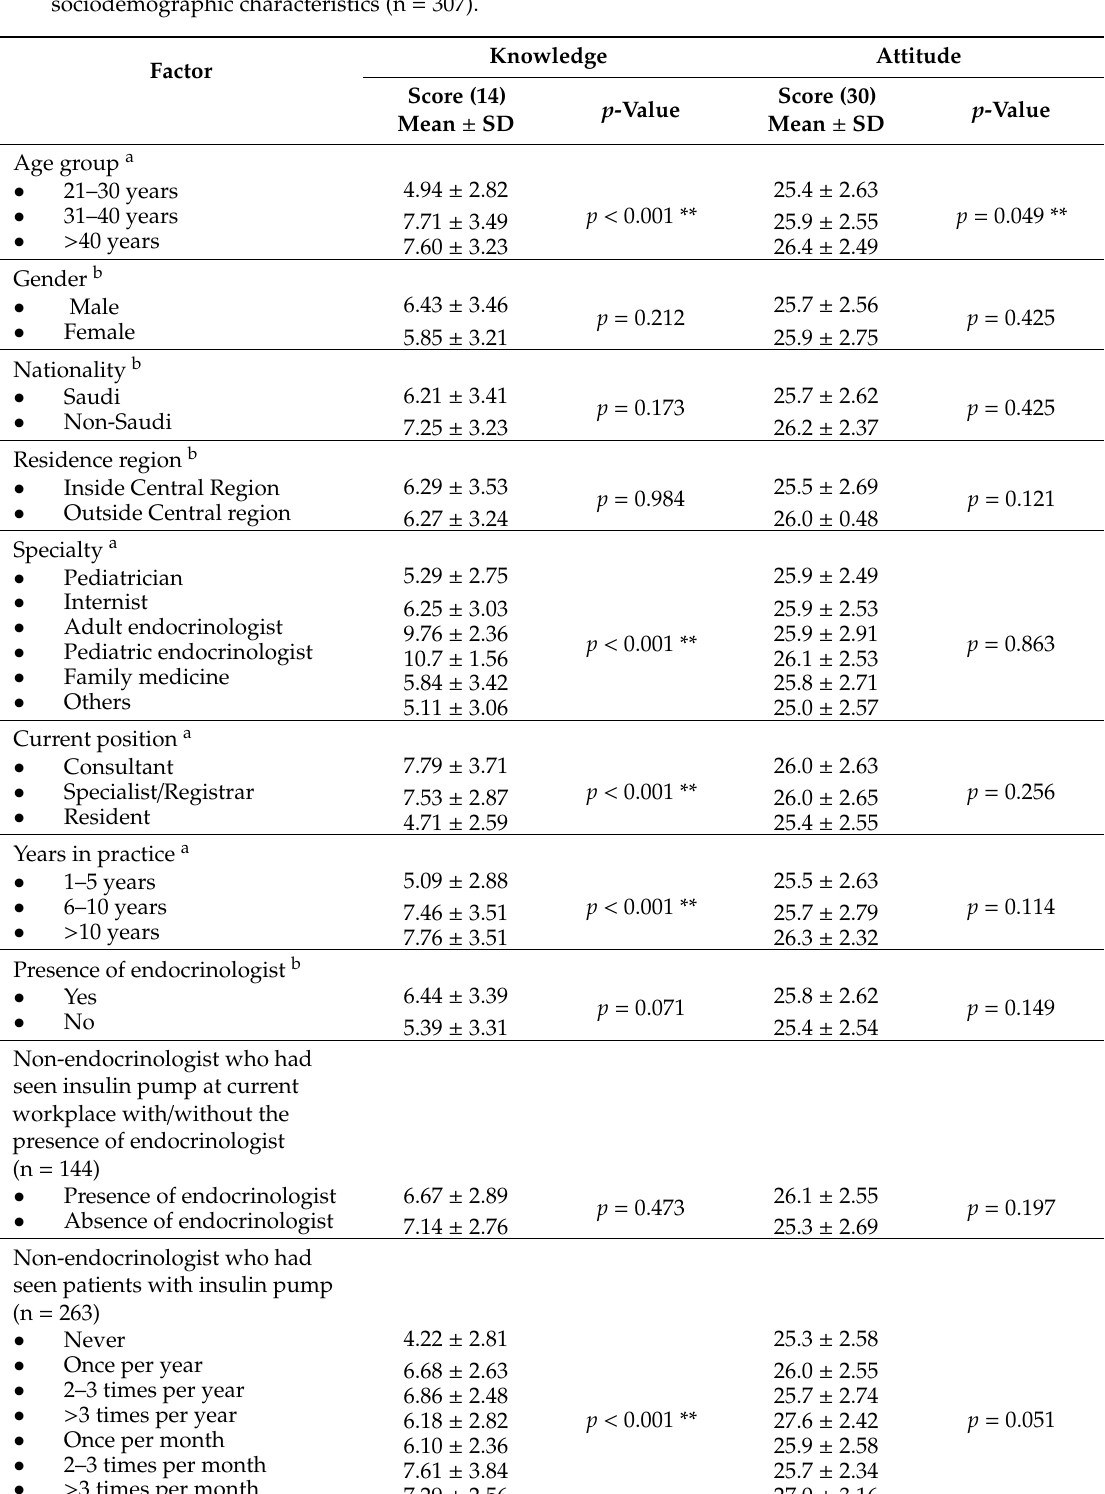
Table 4. Comparison of the mean knowledge and attitude scores according to the physicians’ sociodemographic characteristics (n =